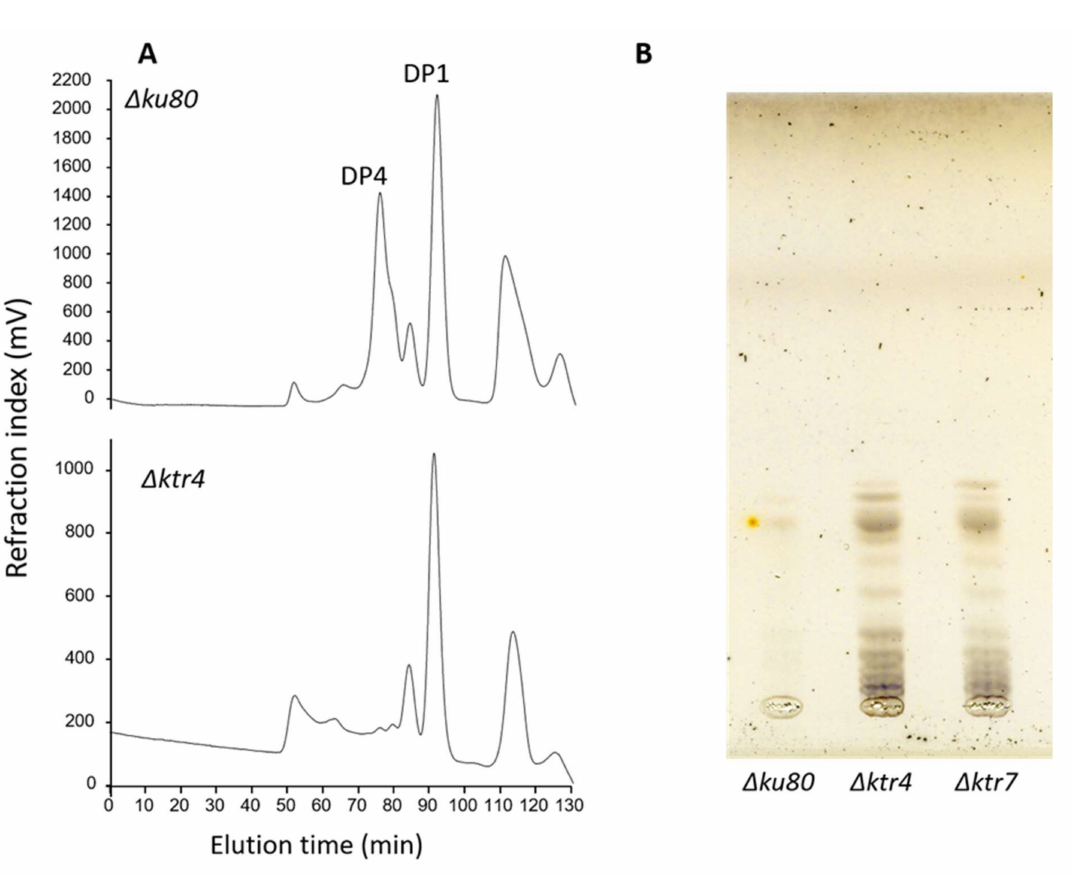
Figure 2. The structures of lipid anchored galactomannans are totally altered in ∆ ktr mutants. ( A ) Analysis by acetolysis of the Lipo-galactomannan like produced by ∆ ktr4 mutant. Lipo-GM fraction was purified from total membrane of mycelium and purified as previously described [18,34]. Mannan structure was analysed by acetolysis degradation and gel filtration chromatography on TSK-40S column. The degradation of Lipo-GM from the parental strain ( ∆ ku80 ) leads to the release to two main products: DP1, corresponding to the galactofuranose that is sensitive to acetolysis and a DP4 corresponding to the tetramannoside repeat unit. Acetolysis cleaves preferentially α -1,6-mannosyl linkage. The degradation of the Lipo-GM produced by the ∆ ktr4 mutant did not release specifically a tetramannoside showing the absence of α -1,2-mannose linked residues. (DP: degree of polymerization). ( B ) TLC analysis of Glycosyl-Inositolphosphoceramide (GIPC) fraction produced by ∆ ktr mutants. GIPC fractions was purified from from total membrane of mycelium and analysed by TLC (Thin layer chromatography), as previously described [36]. In comparaison to parental ∆ ku80 strain, both GM deficient mutants ( ∆ ktr4 and ∆ ktr7 ) produce larger GIPCs in higher